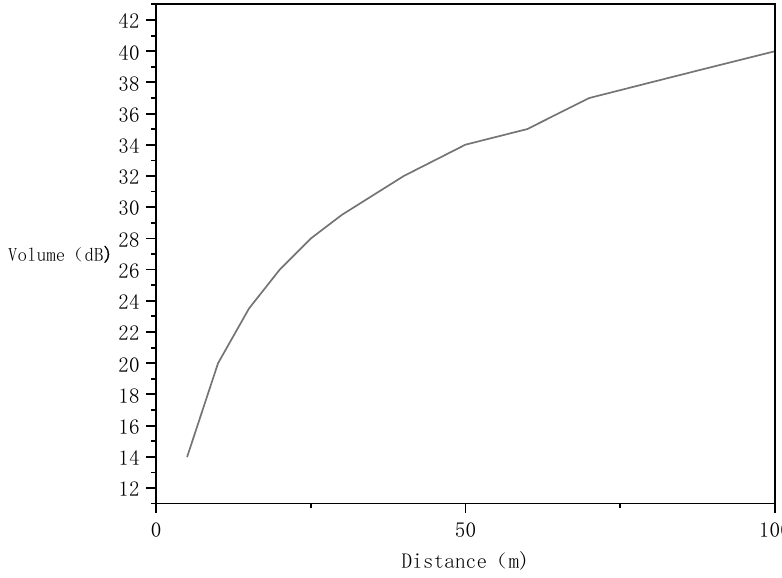
Figure 10. Volume distance correspondence of point source attenuation.